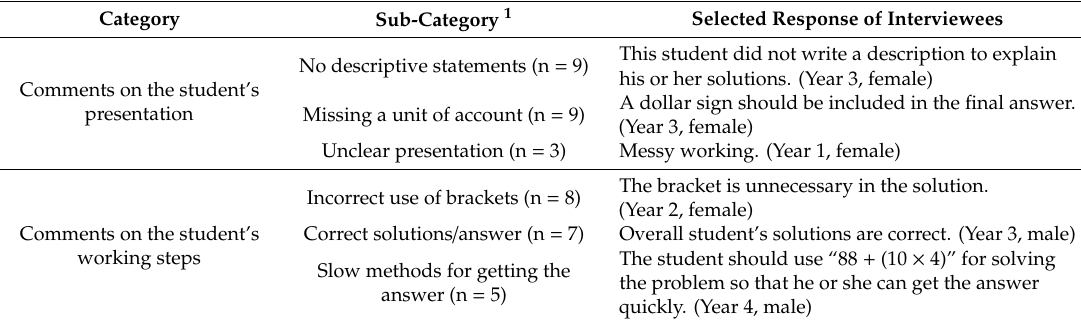
Table 3. Examples for interviewees’ comments on a third grader’s